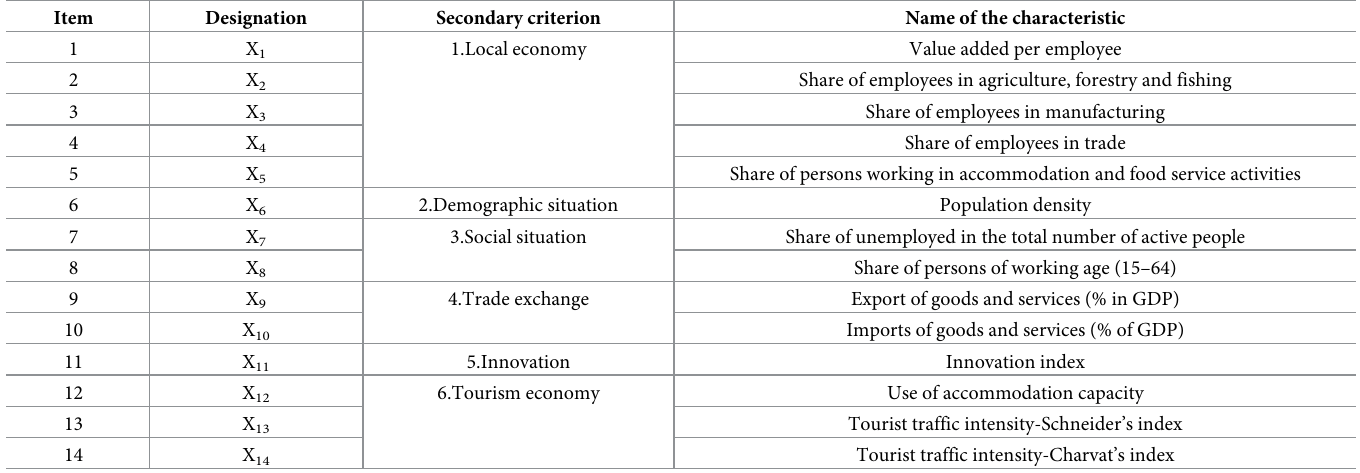
Table 2. Selected diagnostic